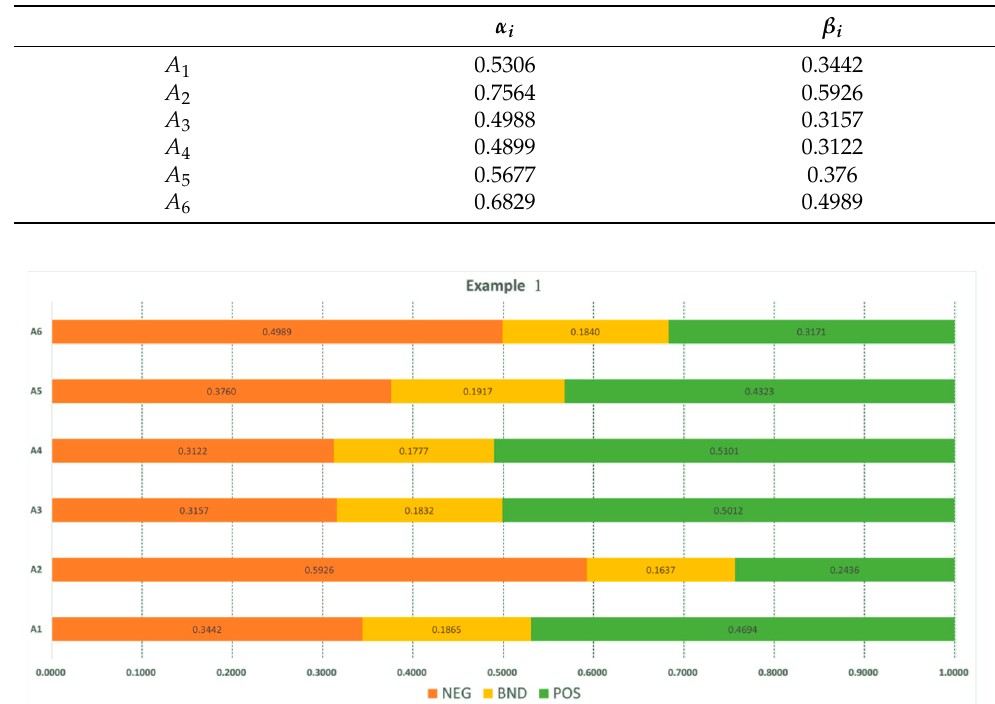
Table 12. The comprehensive thresholds of Example 1.